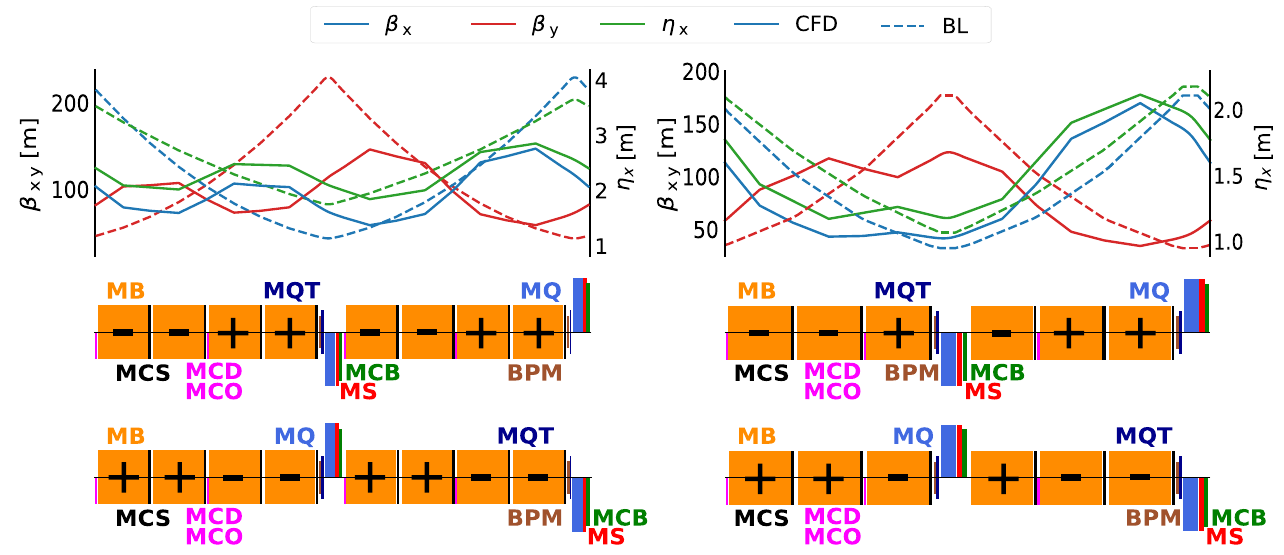
FIG. 13. 18 × 90 FODO-cell (left) and 23 × 90 (right) optics for the baseline (BL) cell and with the use of combined-function dipoles (CFD) for beam 1 (top) and the required quadrupole component (middle). For beam 2 only the required quadrupole components are shown (bottom). The plus and minus signs represent additional positive and negative quadrupole components of (cid:3) 515 × 10 − 4 and (cid:3) 500 × 10 − 4 units, respectively, for the 18 × 90 and the 23 × 90 optics. location. Such a superposition of beam ellipses is seen in Fig. 14 for the 18 × 90 optics at 450 GeV energy. The current beam screen shape in Fig. 14 (left), where offset of 3 . 1 × 10 − 4 has been selected to plot the beam